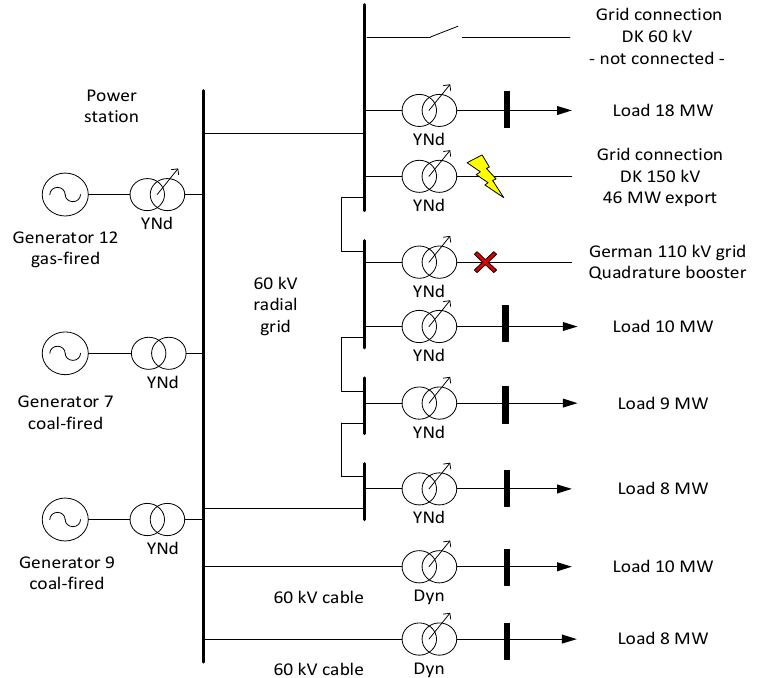
Figure 1. Schematic depiction of the distribution grid in Flensburg, the connected generators, export lines, and the aggregated loads shortly before the blackout on 9 January 2019.